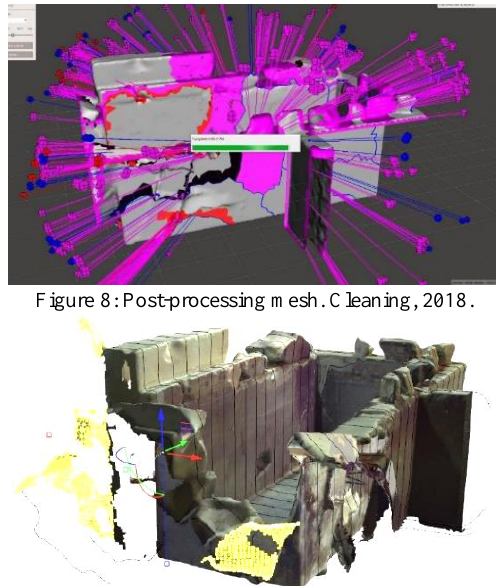
Figure 8: Post-processing mesh. Cleaning, 2018.